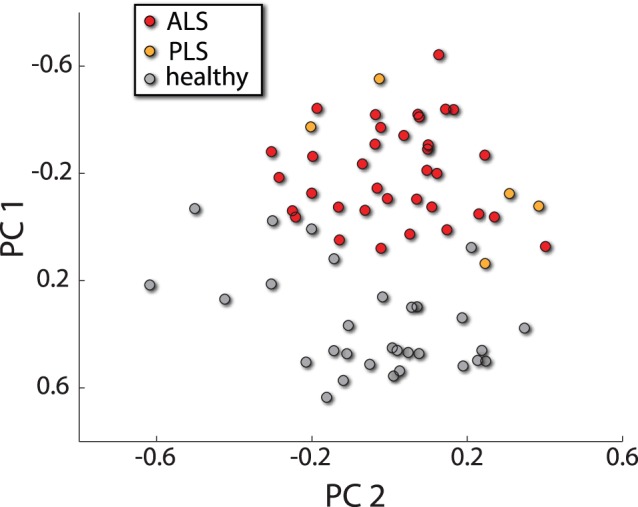
A graphical representation of classification results.The features and ROIs implicated by the classifier were embedded into 2D using principal component analysis.